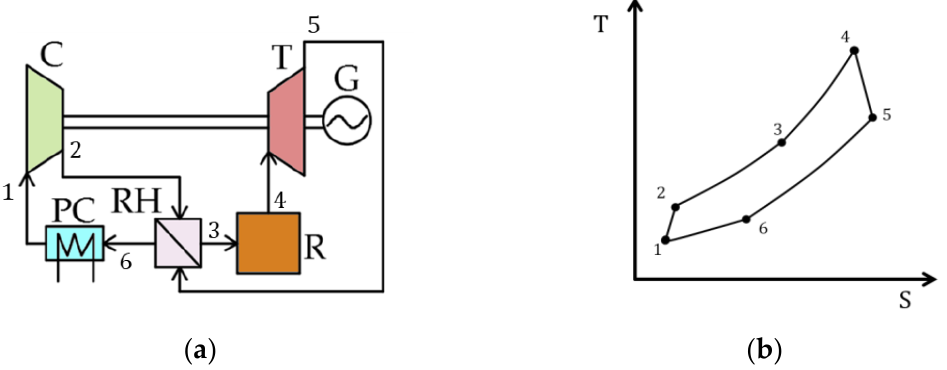
5 of 38 Figure 1. Cycle proposed by Gokhshtein and Verkhivker: ( a ) schematic diagram; ( b ) T – S diagram [11]. B — boiler; LPT — low-pressure turbine; HPT — high-pressure turbine; G — generator; Cond. — condenser; P — pump; RH1, RH2, RH3, RH4, RH5 — regenerative heat exchangers.